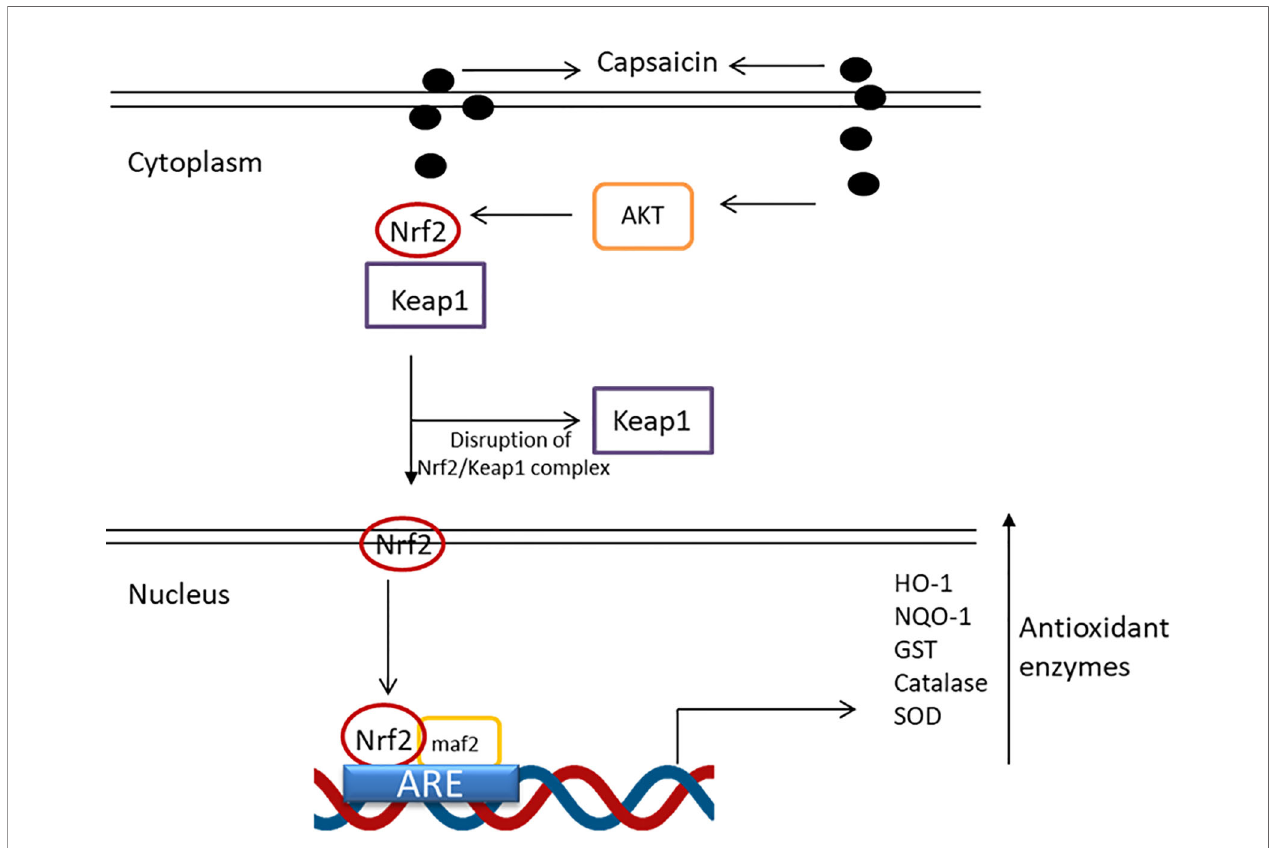
FIGURE 4 | Antioxidant enzyme pathway regulation by